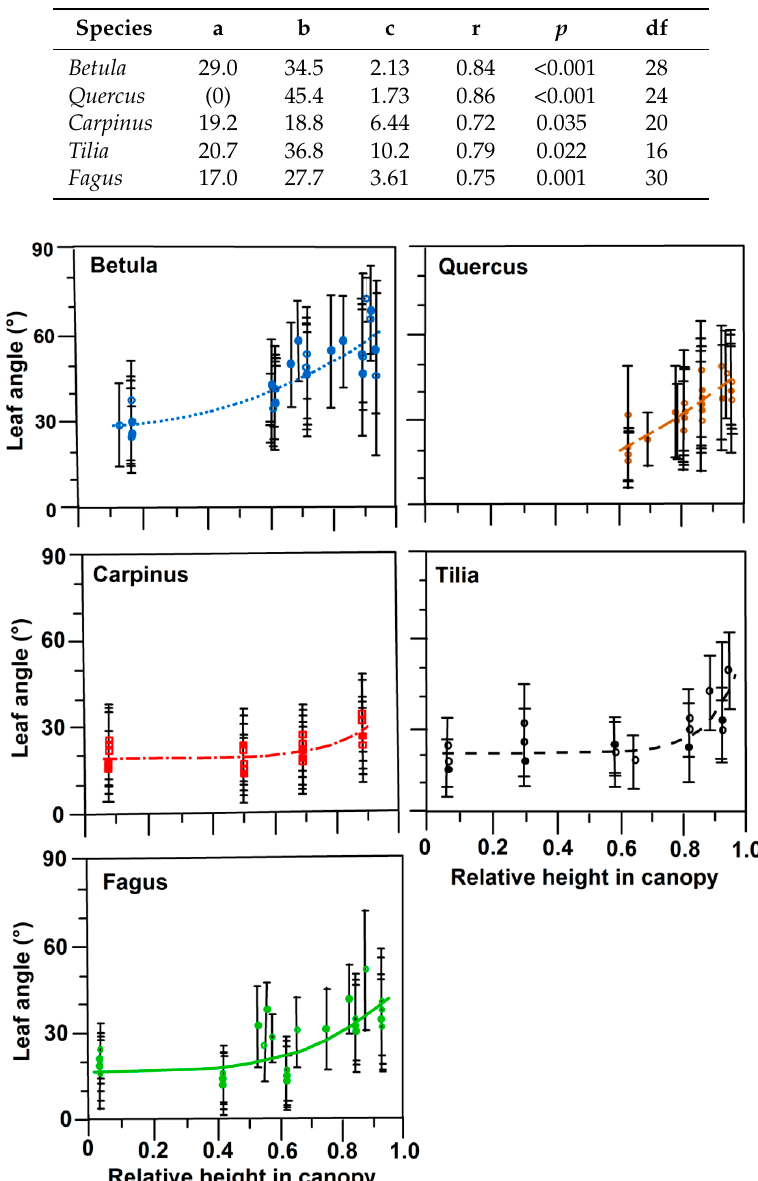
Figure 3. Leaf angles (degrees from horizontal) in dependence on height in the canopy of the five species. Means and SD of each ca. 90 individual measurements taken in early summer (May to early June; filled symbols) or mid to late summer (end of June to early September; open symbols). The influence of season was not significant in any of the species.